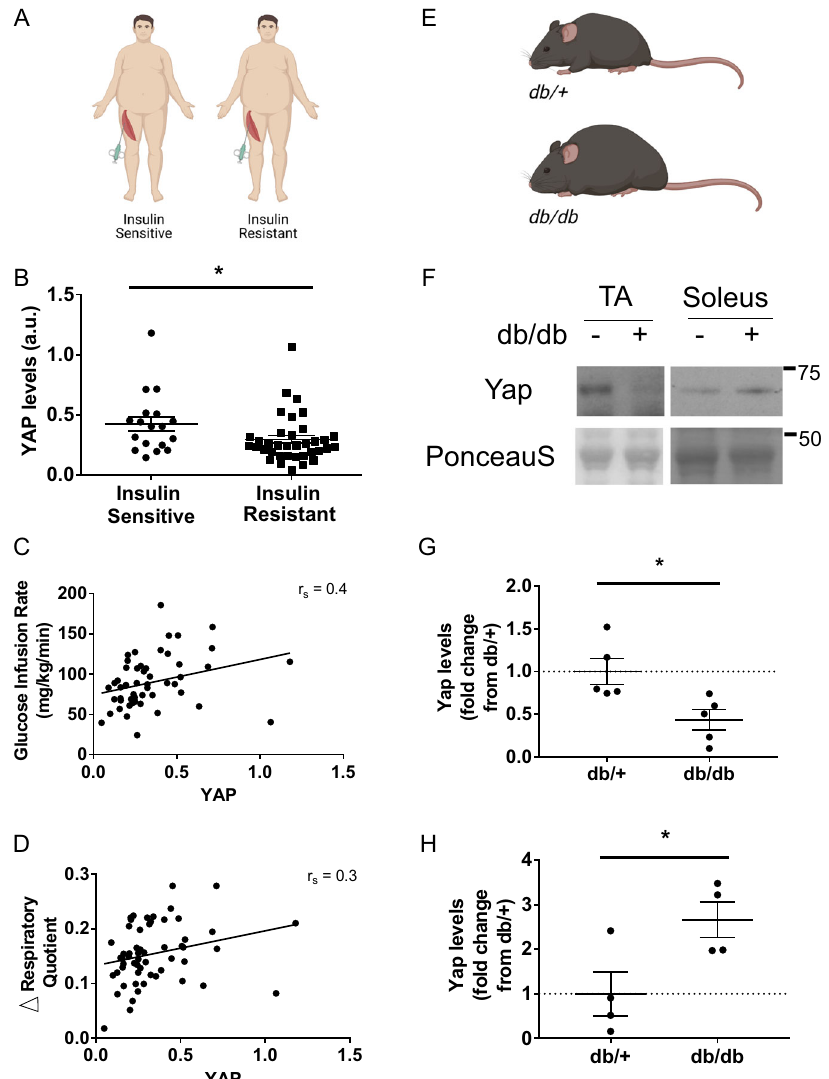
Fig. 1 YAP levels are reduced in insulin-resistant human and mouse skeletal muscles. A Muscle biopsies from the vastus lateralis were obtained from obese individuals who were identi fi ed as insulin-sensitive or insulin-resistant in skeletal muscle, ( B ) total YAP levels in obese, insulin-sensitive and resistant humans ( n = 54 total; 18 insulin sensitive and 36 insulin resistant, mean± SEM, * shows signi fi cant difference, p value = 0.04, two-sided t test), ( C ) YAP levels correlated to glucose infusion rate relative to fat free mass (GIR/FFM; n = 54, r s = 0.4, p = 0.02, and Spearman ’ s rank correlation test), ( D ) YAP levels correlated to difference in respiratory quotient between fasting to glucose-infused state (fed Δ RQ) ( n = 54, r s = 0.3, p = 0.016, and Spearman ’ s rank correlation test), ( E ) Yap levels were assessed in the tibialis anterior (TA) and soleus muscles of lean ( db/ + ) and obese ( db/db ) mice at 6 weeks of age, ( F ) representative western blots of Yap and Ponceau S levels in db/ + ( − ) and db/db ( + ) TA and soleus muscles at 6 weeks of age ( n = 5 and 4 respectively), ( G ) quanti fi cation of total Yap levels in TA samples shown in ( A ) ( n = 5, mean ±SEM, * shows signi fi cant difference, p value = 0.01, two-sided t test), and ( H ) quanti fi cation of total Yap levels in soleus samples shown in ( A ) ( n = 4, mean± SEM, * shows signi fi cant difference, p value = 0.01, two-sided t Hierarchical clustering revealed robust changes in metabolites sections in any muscle group (Supplementary Fig. 4C). Together, these fi ndings demonstrate that reductions in the levels of Yap in adult skeletal muscle fi bres impacts muscle fi bre size indepen- dently of the muscles ’ intrinsic metabolic phenotype.